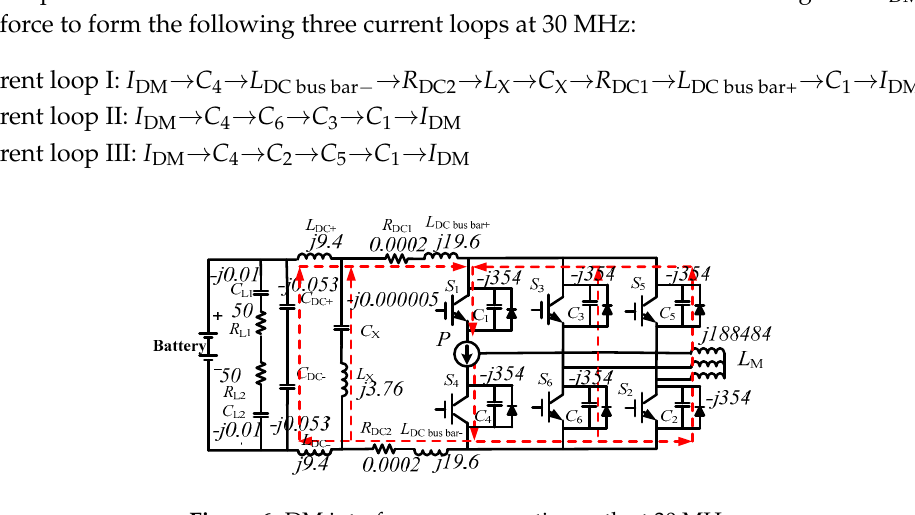
Figure 6. DM interference propagation path at 30 MHz.